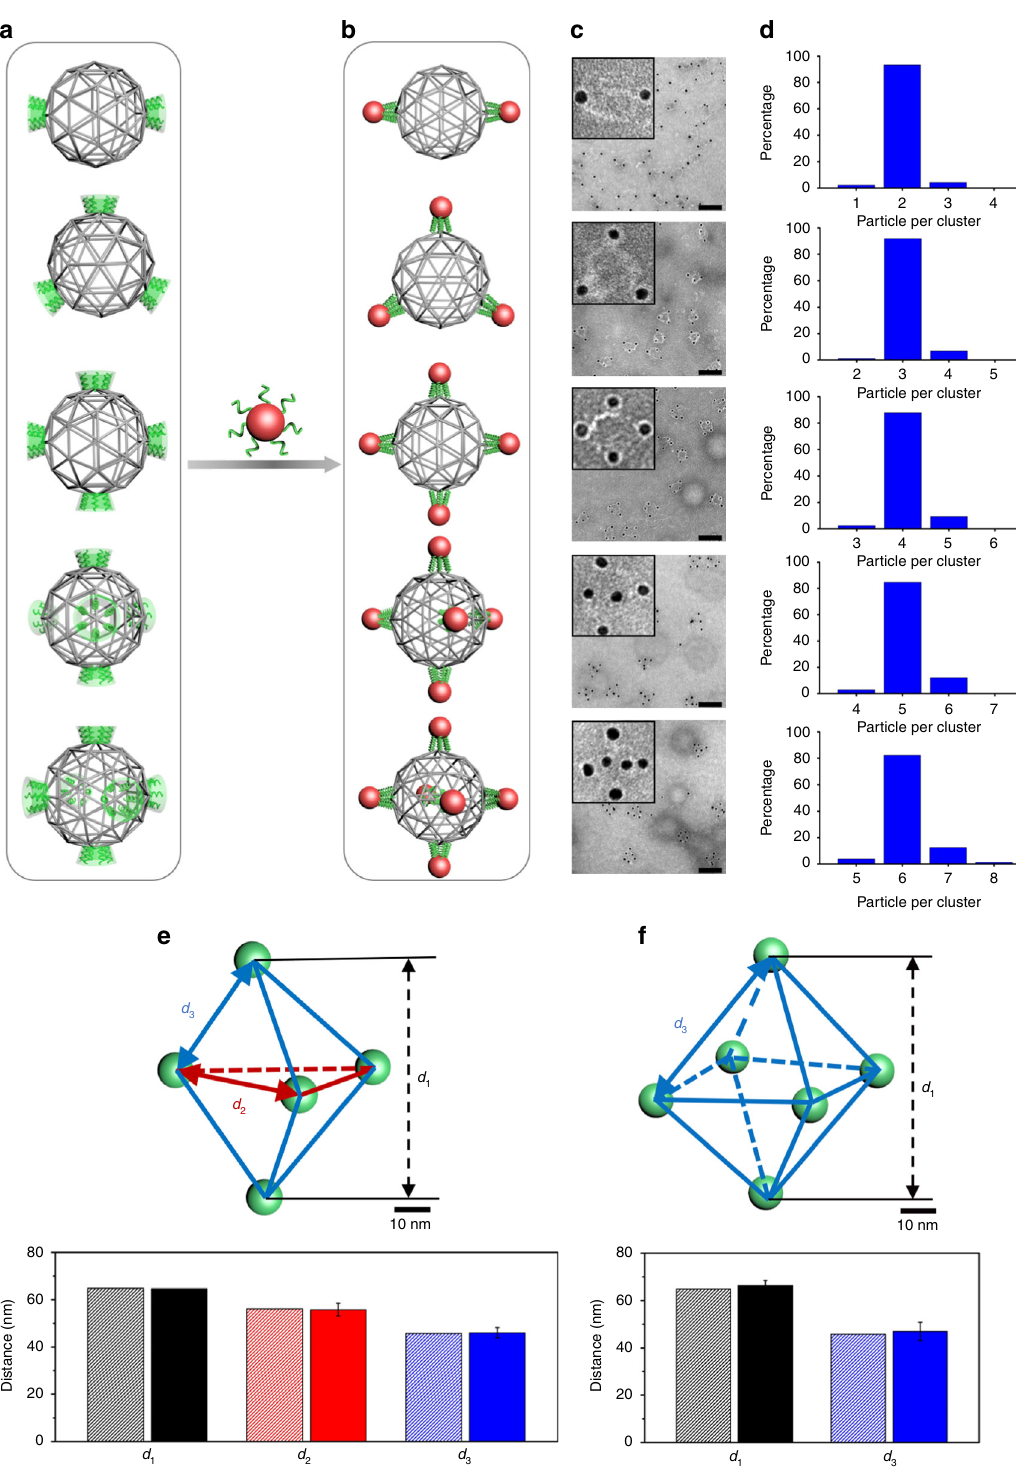
nanocluster. For the square nanocluster, two types of interparticle distances, d 1 between diagonal nanoparticles and d 3 between adjacent nanoparticles, exist. The average interparticle distances for fi ve-cluster architectures are d 1 = 68.1 ± 0.3 nm, d 2 = 58.1 ± 0.1 nm, and d 3 = 47.2 ± 0.3 nm, respectively, which are close to the expected values based on the design: d 1 = 64.8 nm, d 2 = 56.1 nm, and d 3 = 45.8 nm (Fig. 3b, see details in Supplementary Discussion, Interparticle distances of nanoclusters fi tted from